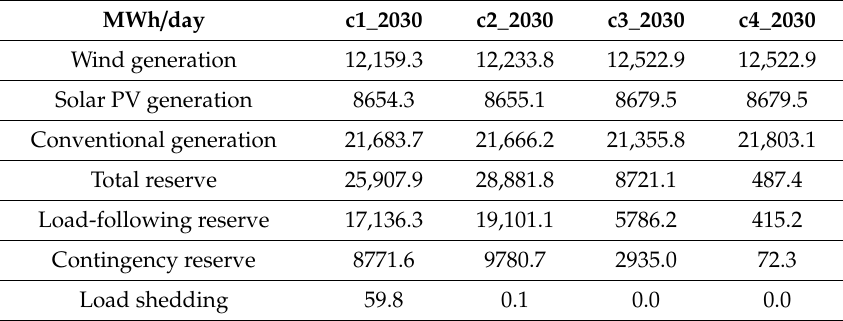
Table 6. Daily generation and reserve for a summer peak day in